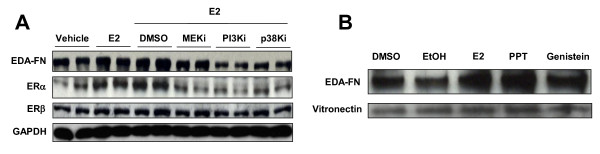
Estradiol promotes fibronectin production via specific signaling cascades. (A) Fibronectin (FN) protein levels in the cellular lysates of normal skin fibroblasts. Normal skin fibroblasts were stimulated with 17β-estradiol (E2) for 48 hours in the presence or absence of the following chemical inhibitors: MEK inhibitor (MEKi), phosphoinositol 3-kinase inhibitor (PI3Ki), and p38 kinase inhibitor (p38Ki). Cellular lysates were analyzed by western blot using anti-EDA-FN, estrogen receptor (ER)α, ERβ, and GAPDH antibodies. (B) Effect of E2 ligands on the expression and deposition of FN in the extracellular matrix (ECM) of normal skin fibroblasts. PPT, propyl-pyrazole-triol. Primary fibroblasts were cultured with vehicle (dimethylsulfoxide (DMSO), ethanol (EtOH)), E2, PPT, or genistein for 48 hours. ECM was analyzed by western blot using anti-EDA-FN and anti-vitronectin antibodies. Ethanol was used as vehicle for E2 and PPT. DMSO was used as a vehicle for genistein.